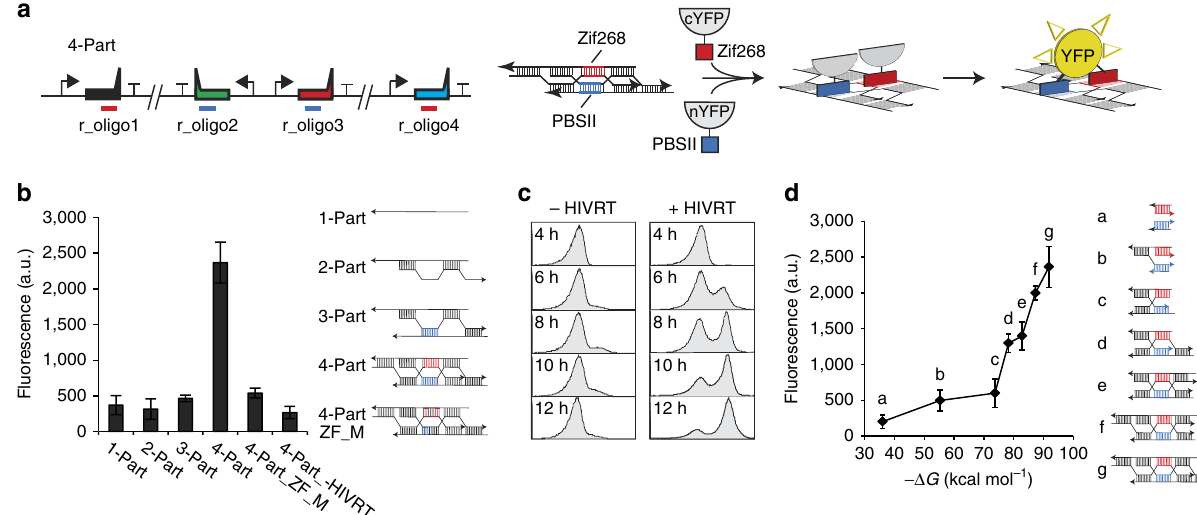
Figure 5 | Intercellular DNA ‘crossover’ nanostructure sensor. ( a ) A schematic of the in vivo sensor is shown. The zinc finger domains are underlined under each of the r_oligo genes and highlighted in the appropriate 10-bp domains formed by the 4-part DNA nanostructure (blue for PBSII and red for Zif268). The split YFPs (nYFP and cYFP, grey) are fused to PSBII and Zif268 and co-expressed using pBAD on the pSC101 plasmid. When all parts are expressed, the proximity of the YFP domains forms the complete protein and fluorescence is detected. The split YFP (nYFP and cYFP) genetic sequences are added in Supplementary Table 4. ( b ) The impact of different combinations of r_oligo genes on the in vivo sensor are shown. The labels (1-part, 2-part and 3-part) refer to the genes present (r_oligo1, r_oligo1/r_oligo2 and r_oligo 1/r_oligo2/r_oligo3). In addition, the oligos were mutated to disrupt the operators (4-part_ZF_Mutant, four bases are mutated in the zif268 domain and five bases in the PBSII domain, coloured black in both domains). Finally, the system was expressed in the absence of HIVRT (4-part_-HIVRT). In all the experiments, 10mM IPTG and 2mM L -ara are added. Data shown represent the averages of three independent experiments performed on different days. The cytometry data and detailed schematic for each system are shown in Supplementary Fig. 10. ( c ) The increase in fluorescence over time is shown for the 4-part system when the sensor is expressed in the absence (-HIVRT) and presence of HIVRT ( þ HIVRT). The inducers (10mM IPTG and 2mM L -ara) are added at time 0h. ( d ) Fluorescence of each different 4-part substructures (a–f) is compared with the fluorescence of the 4-part structure (b). The D G values are calculated using the model described in Supplementary Fig. 12 and based on values from NuPACK 70 . In all experiments, 10mM IPTG and 2mM L -ara are added. Data shown represent the averages of three independent experiments performed on different days. The cytometry data and detailed schematic for each system are shown in Supplementary Fig. 13. The ssDNA sequences are in Supplementary Table 2. NATURE COMMUNICATIONS|7:11179|DOI: